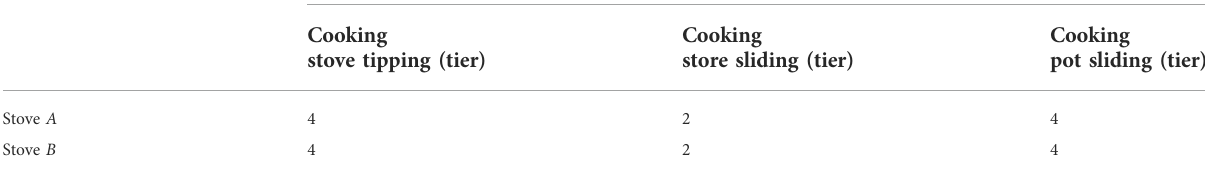
TABLE 6 Ranking of the mechanical stability of Chinese stoves based on the IWA safety protocol tipping